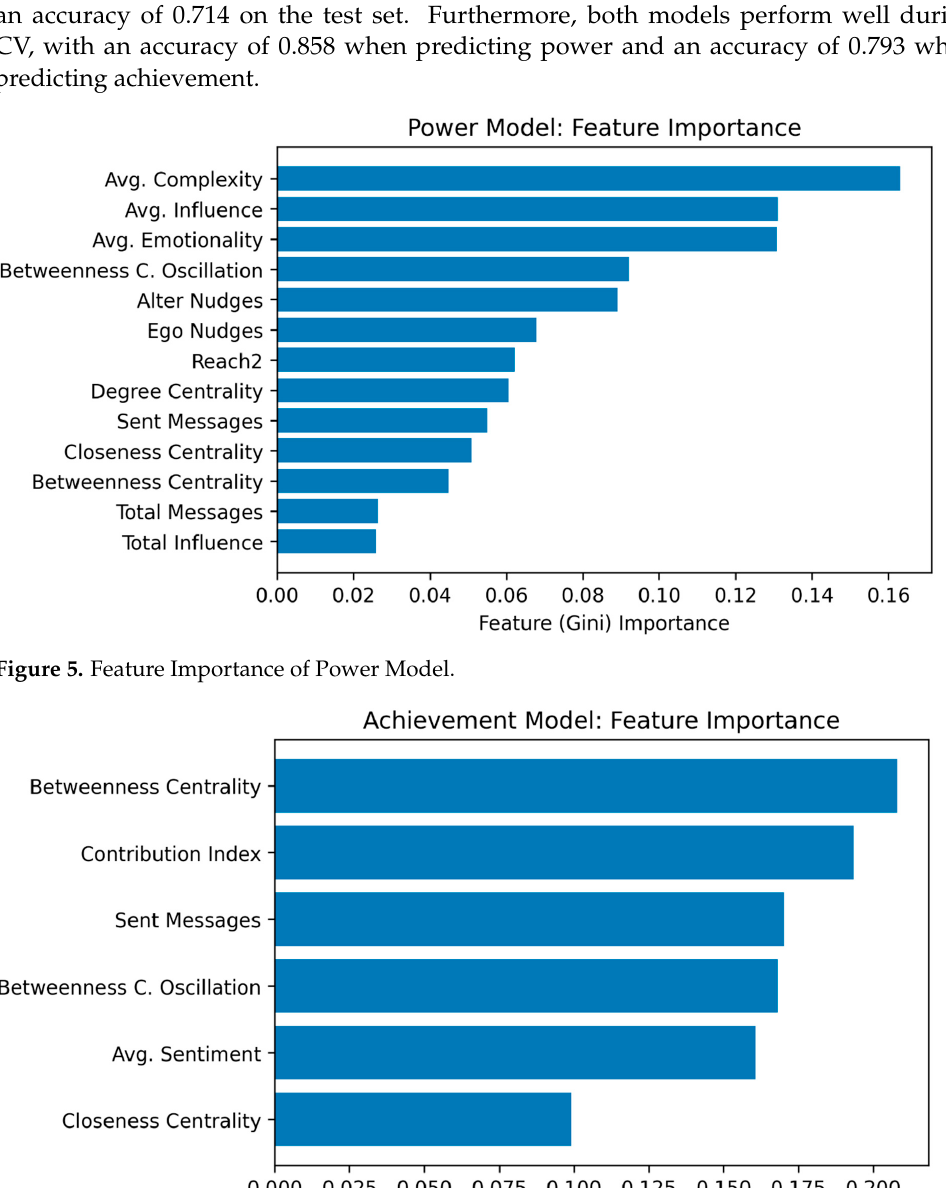
Figure 4. Feature Importance of Authority/Respect Model.